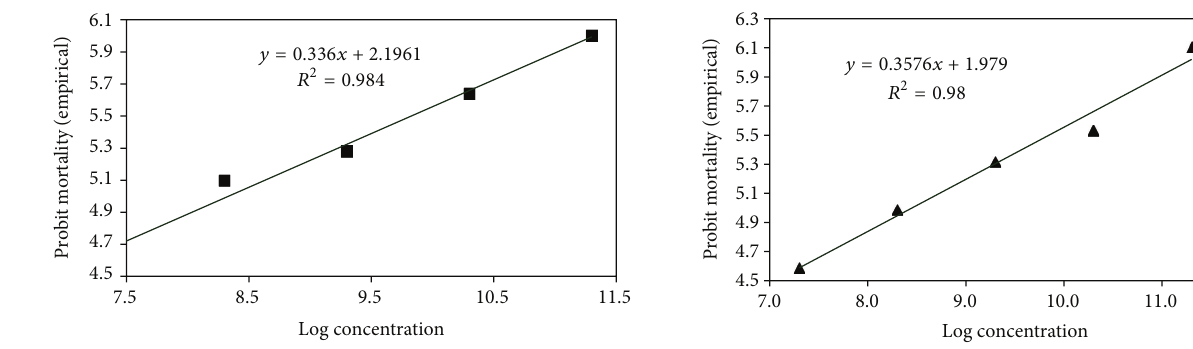
Figure 7: Log concentration probit mortality response of A. disper- sus to L. lecanii (L1 strain).